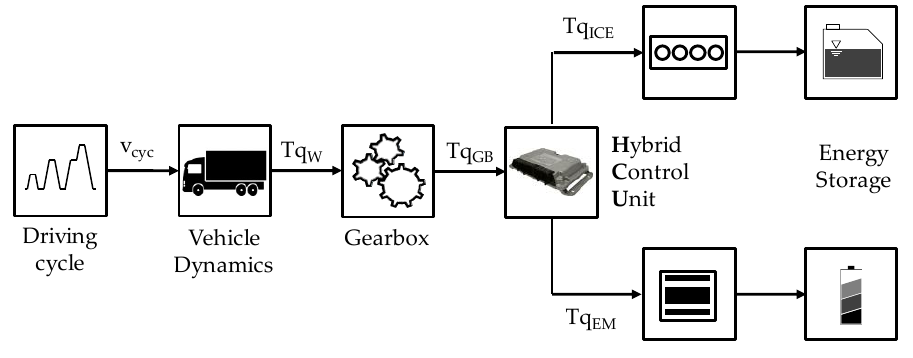
Figure 3. Backward simulation approach.